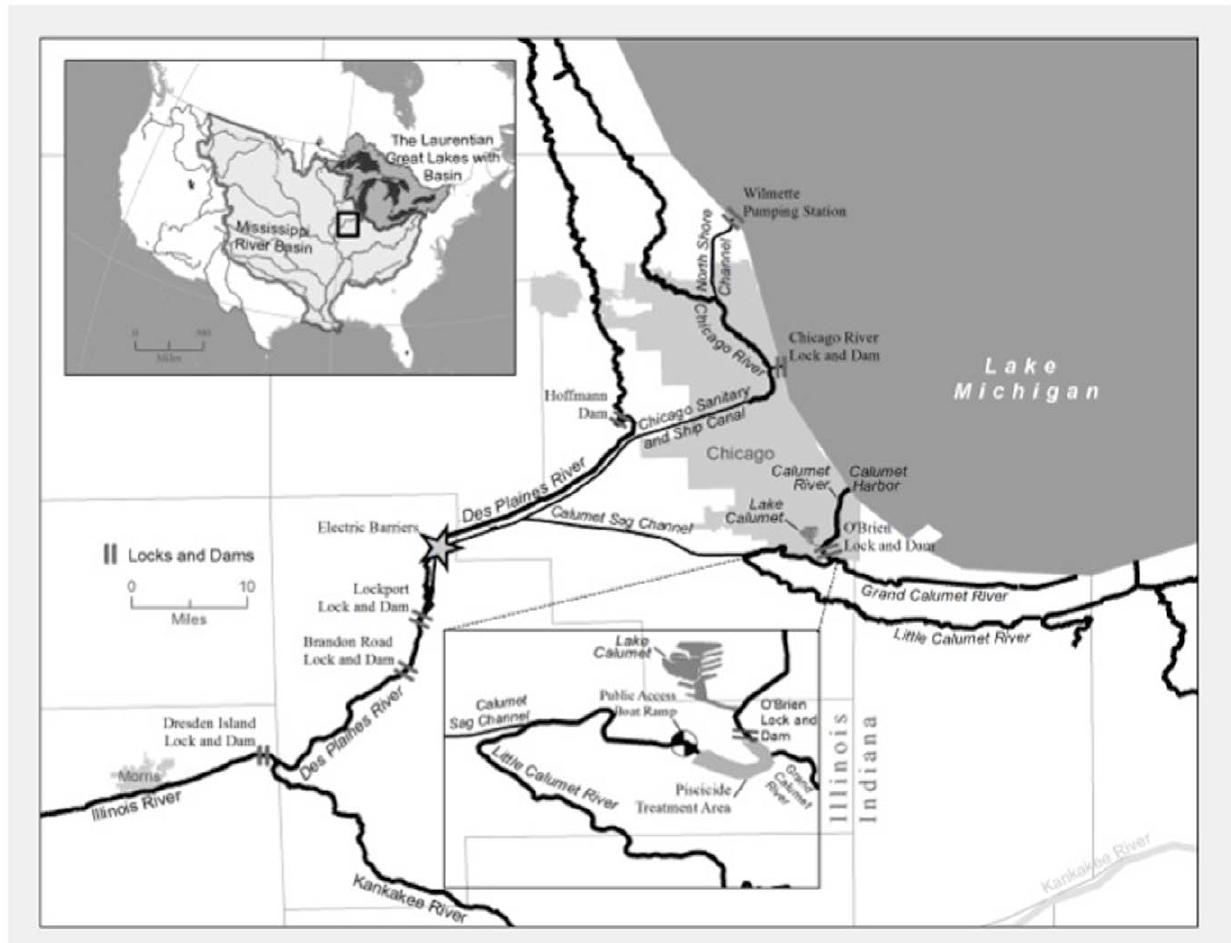
Figure 1. Chicago area waterway system. All field samples reported in this study came from the Little Calumet River at the base of O’Brien Lock. In June of 2010, a bighead carp was recovered from Lake Calumet by the Illinois DNR.